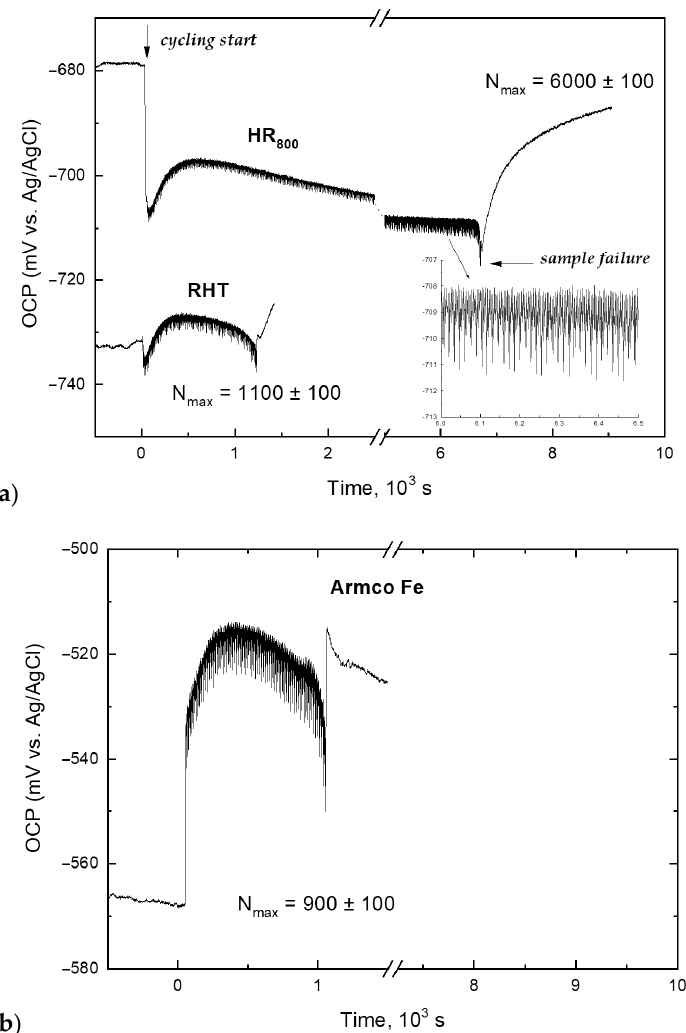
Figure 11. Open-circuit potential curves of alloy samples Fe-30Mn-5Si ( a ) and Armco iron ( b ) in the process of mechanocycling in Hanks’ solution. Arrows show the time points of cycling start and sample failure in ( a ) as an example.